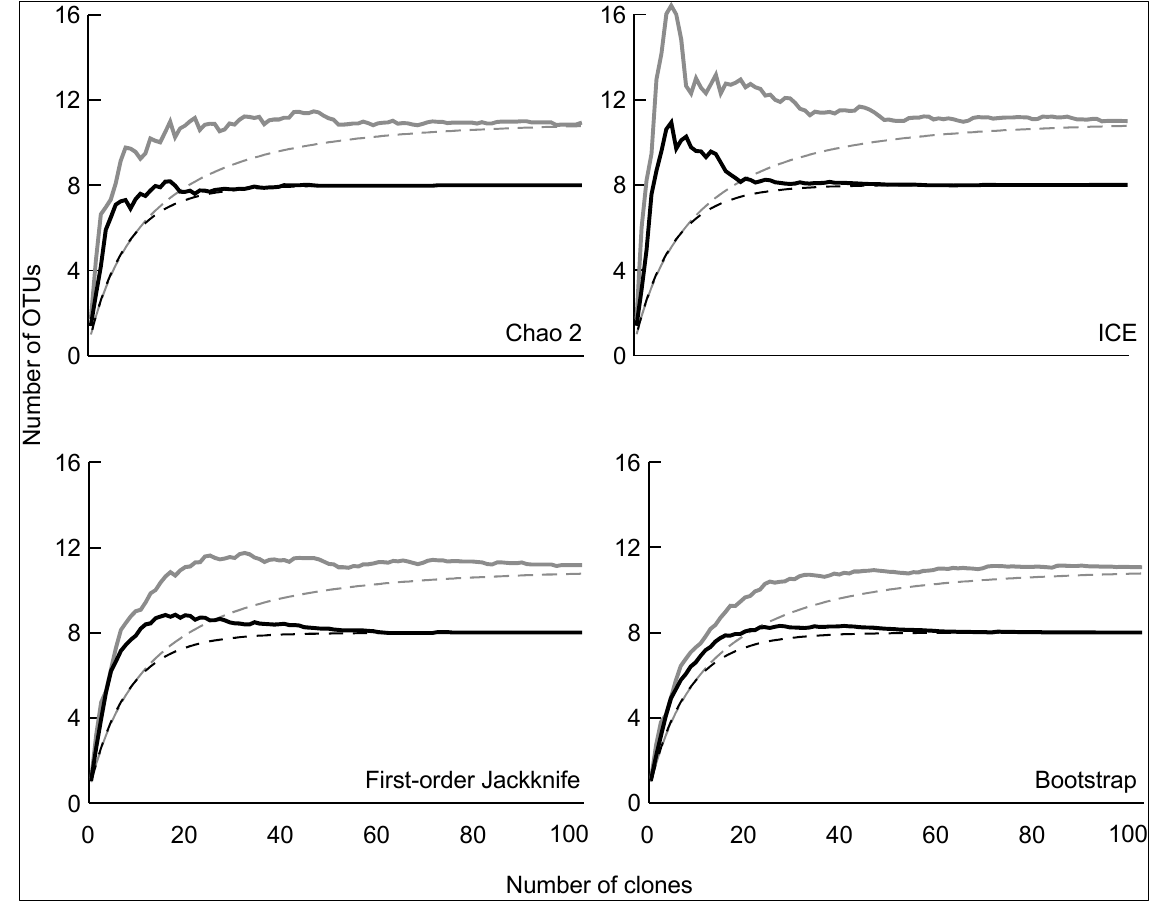
Figure 3. Estimator-based (solid line) and randomized (dashed line) species accumulation curves for near-natural (black) and managed (grey) beech forests obtained with incidence-based coverage (ICE), Chao 2, first-order Jackknife (Jack 1), and bootstrap richness